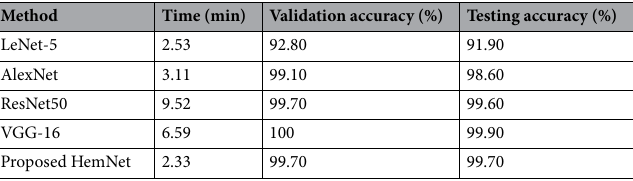
Table 5. Analysis of deep models using time versus classification accuracy on MNIST